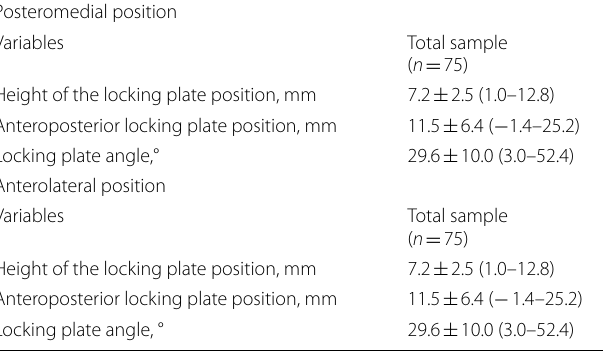
standard deviation with the range in ±